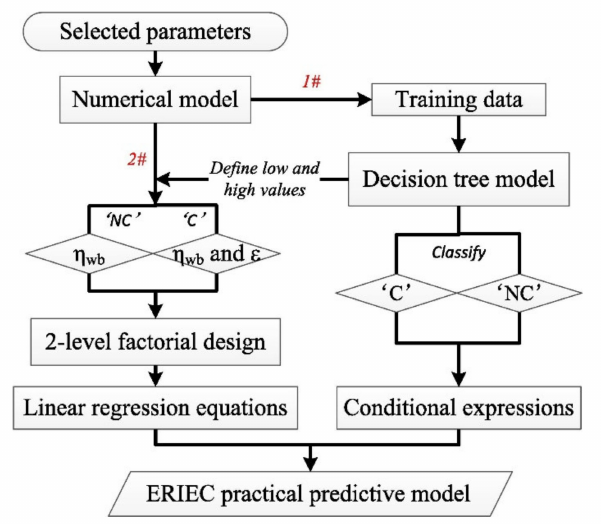
Figure 7. Flow chart for developing a statistical IEC model. Reprinted with permission from Ref. [52]. Copyright 2019,